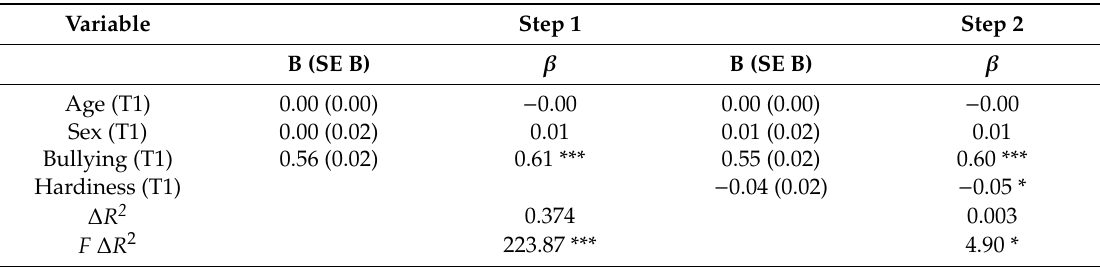
Table 3. Hierarchical multiple regression analysis of exposure to workplace bullying (sum of bullying from T2 to T4) predicted by hardiness at T1, controlled for age, sex, and workplace bullying measured at T1. Unstandardized beta coe ffi cient (B) with standard error (SE B), and the standardized beta coe ffi cient ( β ) are